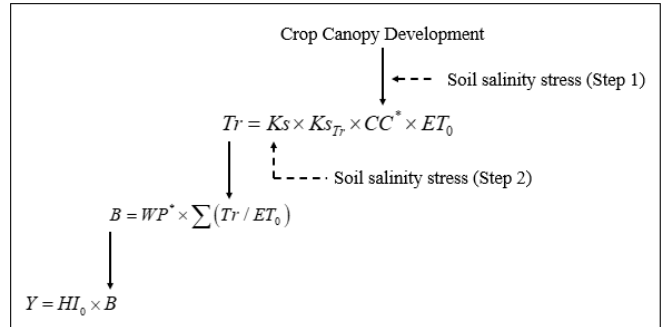
Figure 6. The relationship between salinity and crop yield. CC* : green canopy cover adjusted for micro advection; WP* : the normalized biomass water productivity.